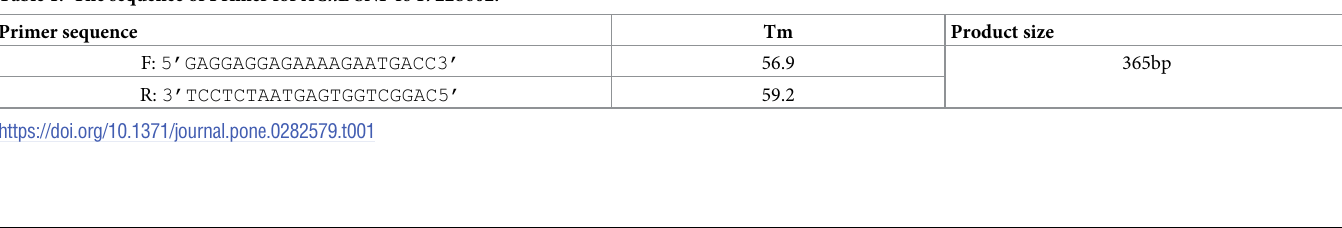
Table 1. The sequence of Primer for AChE SNP rs